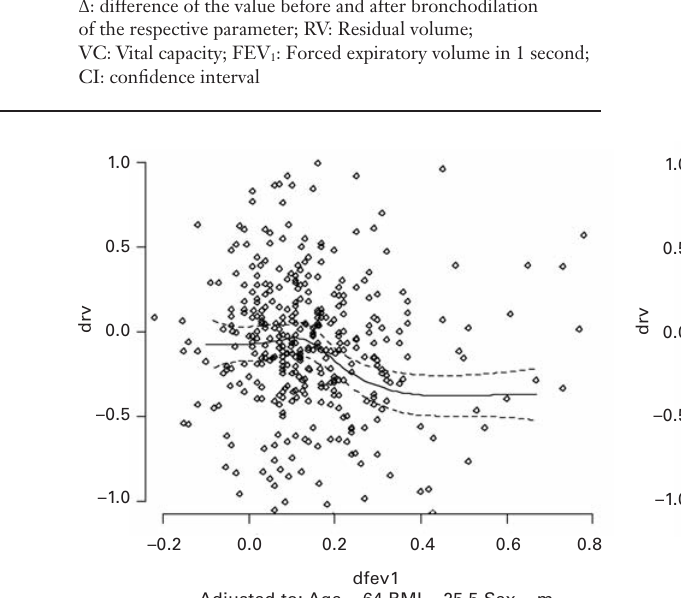
Differences between Δ RV from the 25 th to the 75 th quantile of Δ FEV 1 or Δ